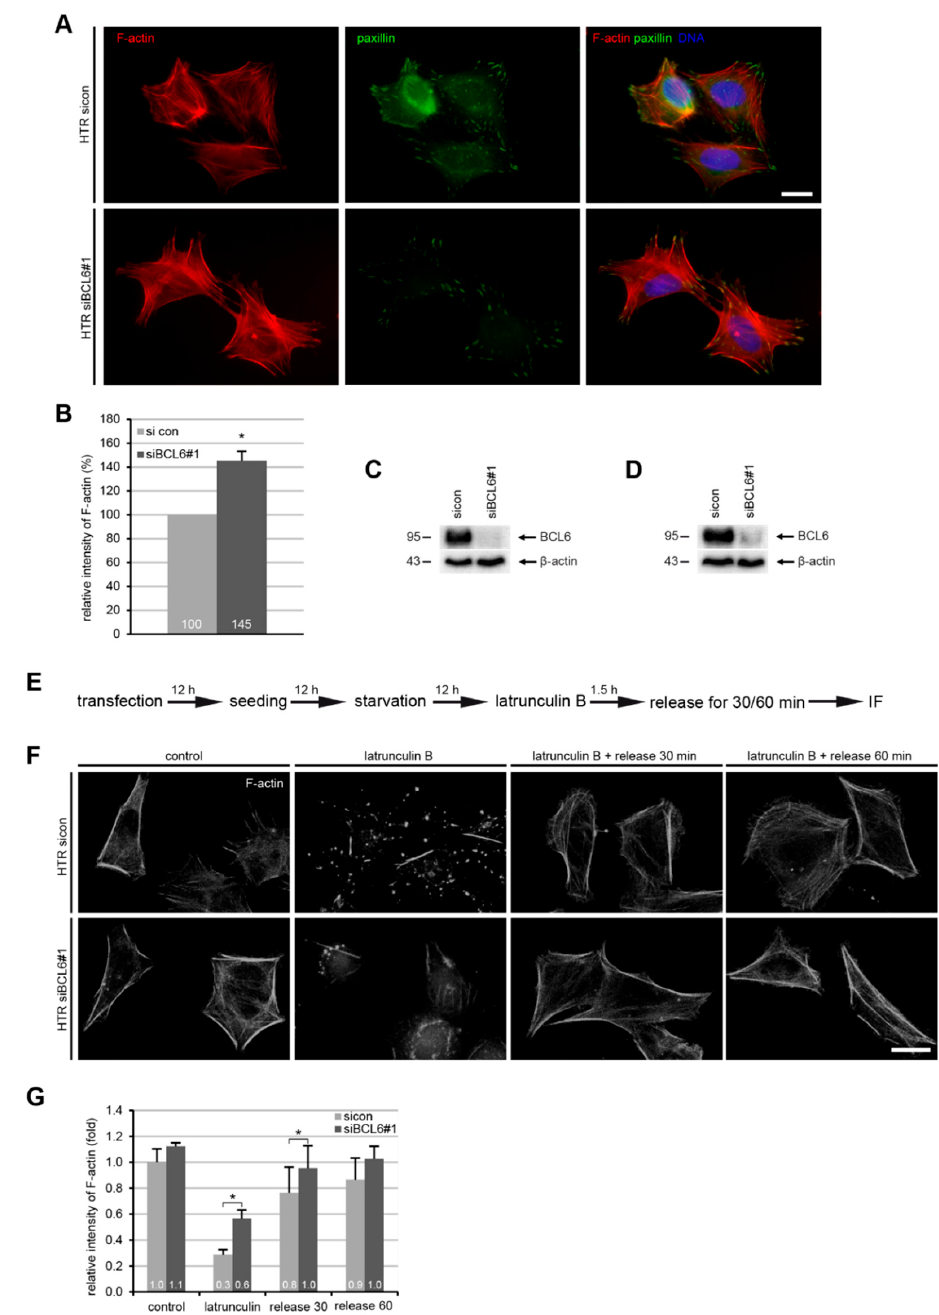
Figure 4. Elevated F-actin and reduced paxillin in HTR cells with reduced BCL6. ( A ) HTR cells, treated with control siRNA (sicon) or siRNA targeting BCL6 (siBCL6#1) for 24 h, were stained for F-actin and paxillin for microscopic evaluation. Representatives are shown. Scale: 25 µm. ( B ) The relative intensity of F-actin was measured in treated HTR cells (200 cells for each condition). The results were obtained from three independent experiments and are presented as the mean ± SEM. * p < 0.05. ( C ) Western blot analysis as the transfection efficiency control for ( A , B ). Β -actin served as the loading control. ( D ) Western blot analysis as the transfection efficiency control for ( F , G ). β -actin served as the loading control. ( E ) Schedule of the latrunculin B washout experiment. HTR cells, transfected with sicon or siRNA BCL6#1 for 24 h, where 10 µM latrunculin B was added into the medium for 90 min, and after 30 and 60 min, cells were released into fresh prewarmed culture medium. ( F ) Cells were stained